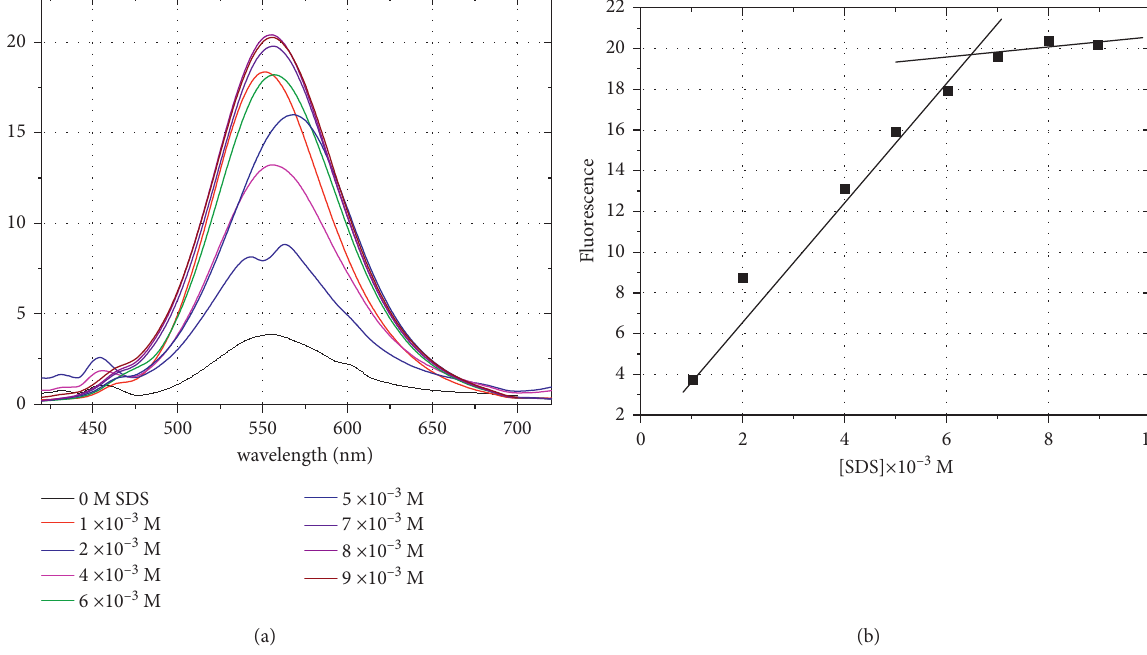
� 500nm)(b) of coumarin 3 (1 × 10 − 5 M) in ethanol/glycerol mixtures with ex